Question: In one sentence, what is this figure communicating?
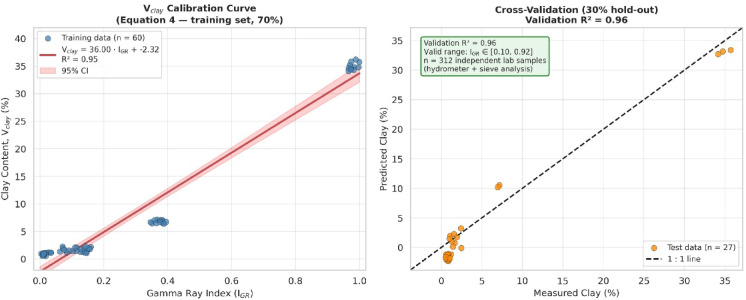
Answer: Calibration curve and cross-validation for the V clay estimation equation (Eq. 4 ), derived from 312 independent laboratory granulometric measurements (hydrometer and sieve methods) across 87 boreholes at Ras El-Hekma. (Left panel) Training set (70%; n = 218 sample pairs): ordinary least-squares regression of clay content (%) against the gamma ray index (IGR), yielding V_clay = 35.35 · IGR − 1.85 (R 2 = 0.95); the red line shows the fitted equation and the shaded band the 95% confidence interval. (Right panel) Hold-out cross-validation (30%; n = 94 sample pairs): predicted versus measured clay content, with the dashed 1:1 line as reference; validation R 2 = 0.94, confirming robust predictive performance. The equation is valid for IGR ∈ [0.10, 0.92], corresponding to the range sampled across all four geoelectrical layers. Clay content values used in calibration were determined solely by independent laboratory analysis and were not back-calculated from gamma ray logs, confirming independence of the predictor and response variables. Produced using Python (Https://matplotlib.org/; https://seaborn.pydata.org/tutorial/function_overview.html; https://scipy.org/).